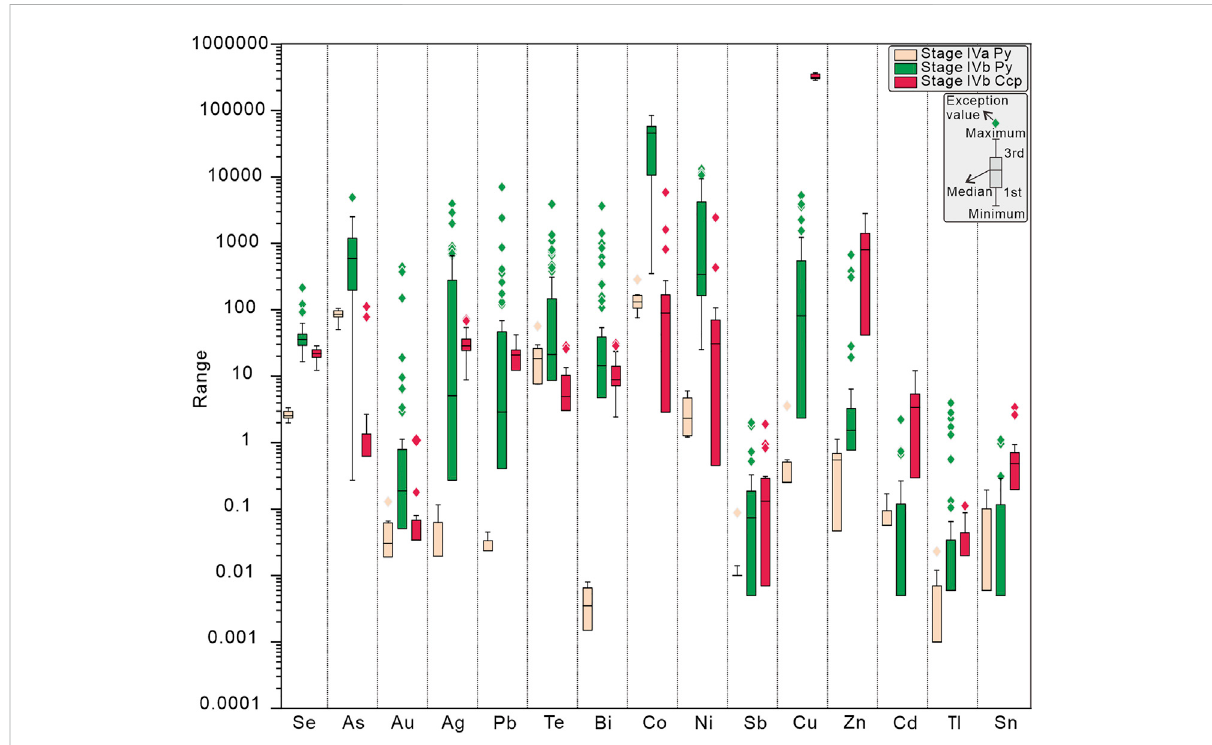
FIGURE 9 Trace element distribution diagram showing the variation in the Se, As, Au, Ag, Pb, Te, Bi, Co, Ni, Sb, Cu, Zn, Cd, Tl, and Sn concentrations (in ppm) for pyrite and